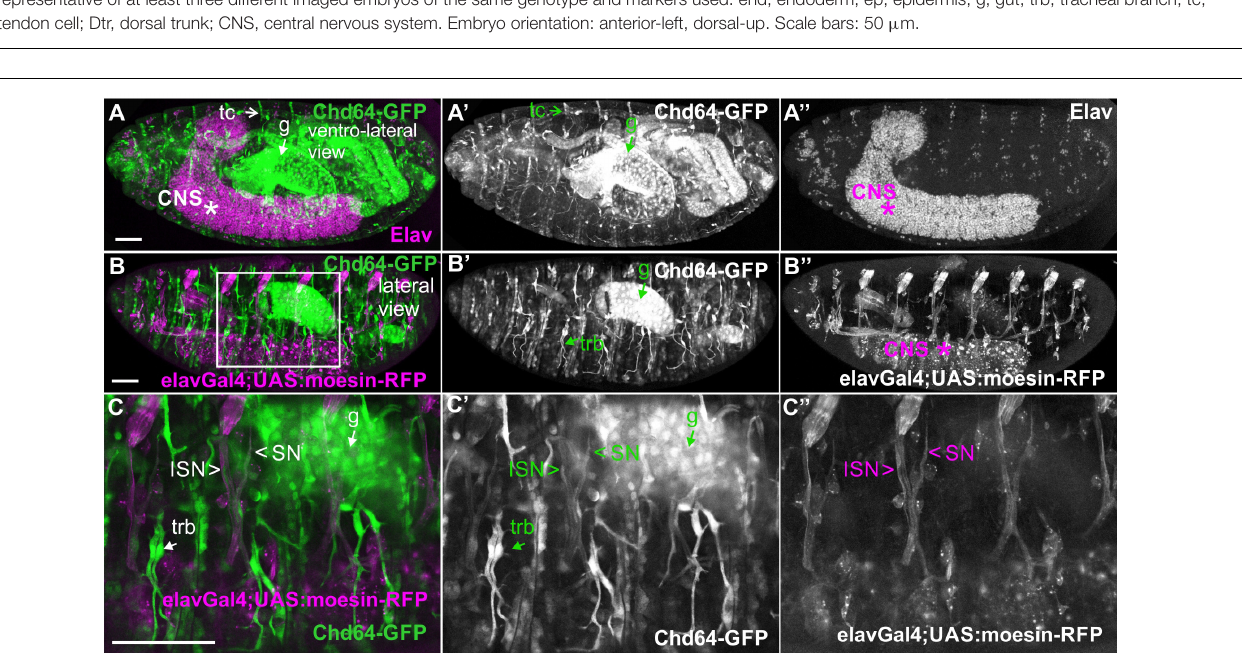
FIGURE 3 | Chd64 protein accumulation in the developing embryo. (A–C) Living embryos expressing Chd64-GFP. (A) In stage 12 embryo, Chd64-GFP is detected in gut primordial cells and epidermally associated structures localized at the segment borders. (B) In stage 14 embryo, Chd64-GFP further accumulates in the alimentary track and epidermally associated structures localized at the segment borders. (C) In late stage 17 embryo, Chd64-GFP protein is heavily enriched in the gut, tracheal branches, and epidermal cells in a similar identified pattern. (D–F) Different embryos viewed dorsolaterally (D) and ventrolaterally (E,F) , expressing UAS:GFP under the stripeGal4 which marks the tendon cells and probed with an antibody against Chd64. (D) A higher number of tendon cells located in the dorsal side of the embryo express Chd64 and colocalize with GFP. (E) In the ventral side of the embryo, the number of tendon cells expressing Chd64 is significantly lower. (F) The reduced number of tendon cells expressing Chd64 is clearly illustrated in the high-magnification image. Tracheal branches are evident in all views of the embryo and clearly depicted in the high-magnification image in panel (F) . (G) Horizontal single optical section of an embryo, to clearly demonstrate the expression of Chd64 in tendon cells. (H–H (cid:48)(cid:48)(cid:48) ) Dorsal and (I–I (cid:48)(cid:48)(cid:48) ) ventral view of stage 15 fixed embryo expressing the trachea-specific marker pointedlacZ (green) and probed against Chd64 (red) and Fasciclin III (blue) proteins. (H (cid:48) ,I (cid:48) ) pointedlacZ expression marks the nuclei of tracheal branches and colocalizing with Chd64 detected protein (H (cid:48)(cid:48) ,I (cid:48)(cid:48) ) ; FasIII labels the (H (cid:48)(cid:48)(cid:48) ) epidermis and (I (cid:48)(cid:48)(cid:48) ) CNS. (J,K) Fixed embryos probed against Chd64 along with ectopic expression of btl-Gal4; UAS-GFP to highlight tracheal branches. (J–J (cid:48)(cid:48) ) In stage 15 embryo, the newly formed secondary branches of trachea marked by GFP expression are characterized by significant accumulation of Chd64 protein. (K–K (cid:48)(cid:48) ) In stage 16 embryo, Chd64-GFP is clearly accumulated in the long extensions of tracheal branches. Each image is representative of at least three different imaged embryos of the same genotype and markers used. end, endoderm; ep, epidermis; g, gut; trb, tracheal branch; tc,